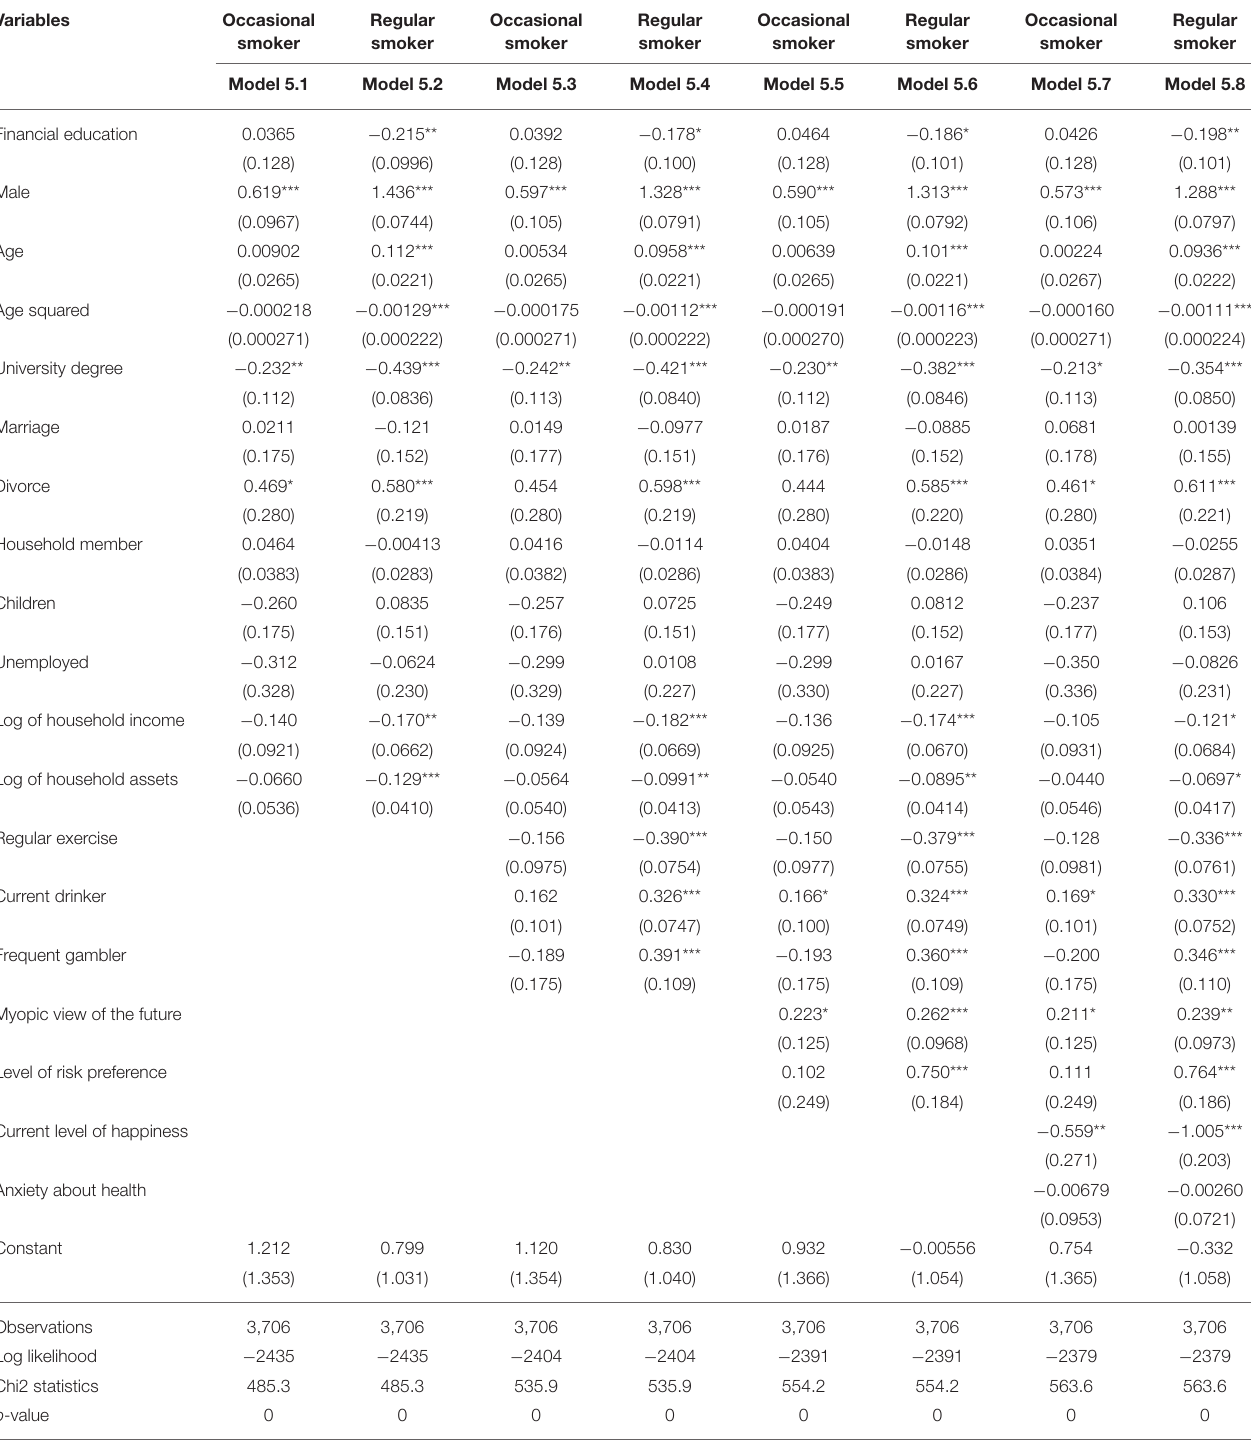
TABLE 10 | Multinomial probit model regression results, financial education as the main explanatory variable.